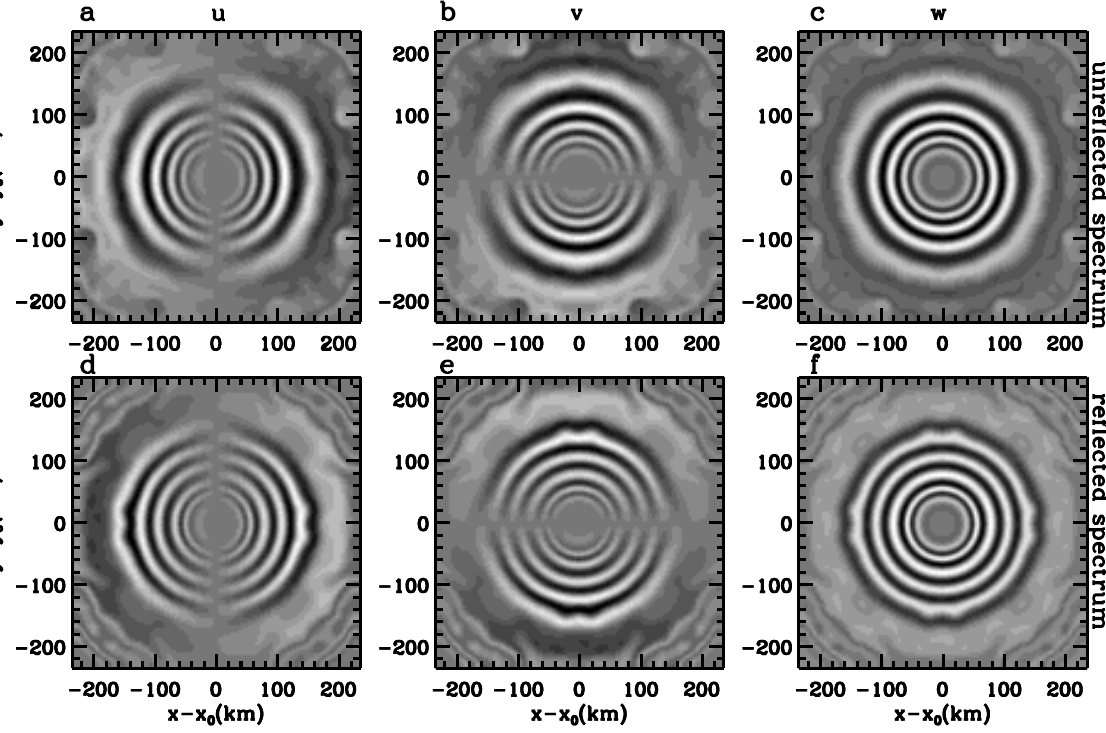
Fig. 11. Horizontal slices of the reconstructed u , v and w fields from ray tracing at z = 70km and t = 55min. Upper row shows the results using the unreflected GW spectrum (Fig. 2a–b), while the lower row shows the results using the reflected GW spectrum (Fig. 2c–d). From left to right, the maximum values of u , v , and w are: 1st row: 17, 17 and 11ms − 1 . 2nd row: 14, 14 and 9ms − 1 . The resolution is 1x = 8 .